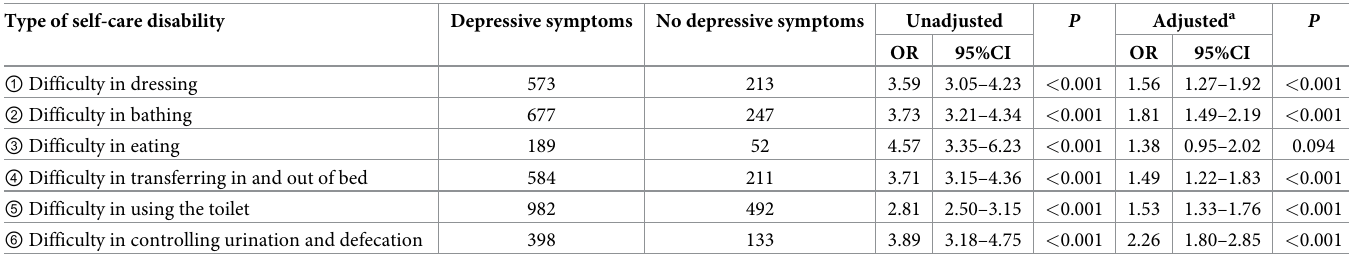
Table 3. Crude and adjusted odds ratios (OR) for the associations between types of self-care disability and depressive symptoms. Type of self-care